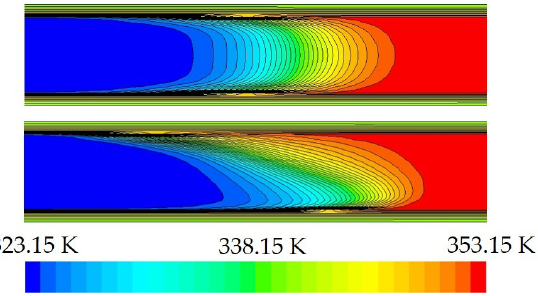
Figure 28. Effect of gravity on the temperature distribution of cold wave (the upper picture shows the temperature front without effects of gravity, the lower picture shows the contrary). temperature front without effects of gravity, the lower picture shows the